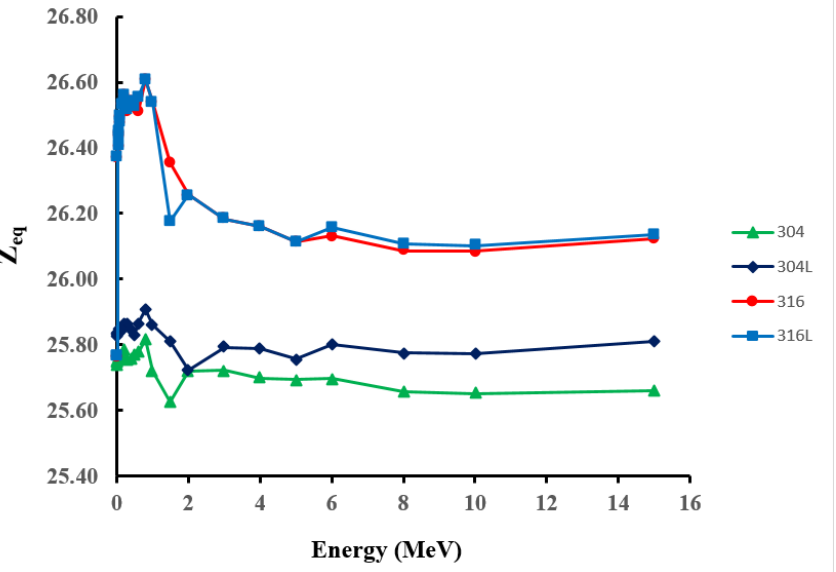
Figure 4. Equivalent atomic number ( Z eq ) results for the studied stainless-steel samples in the energy range 0.015–15